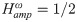
Division of critical exponents into meta-universality classes.The figure displays the range of qualitative behaviours we predict with our theory. Areas marked in green display no LRTC behaviour in sub-bands or DCCA correlations between sub-bands. Areas in red display LRTC and/or cross correlations between amplitudes of sub-bands (Hampω=1/2, ρDCCA(n) = 0 for large n).